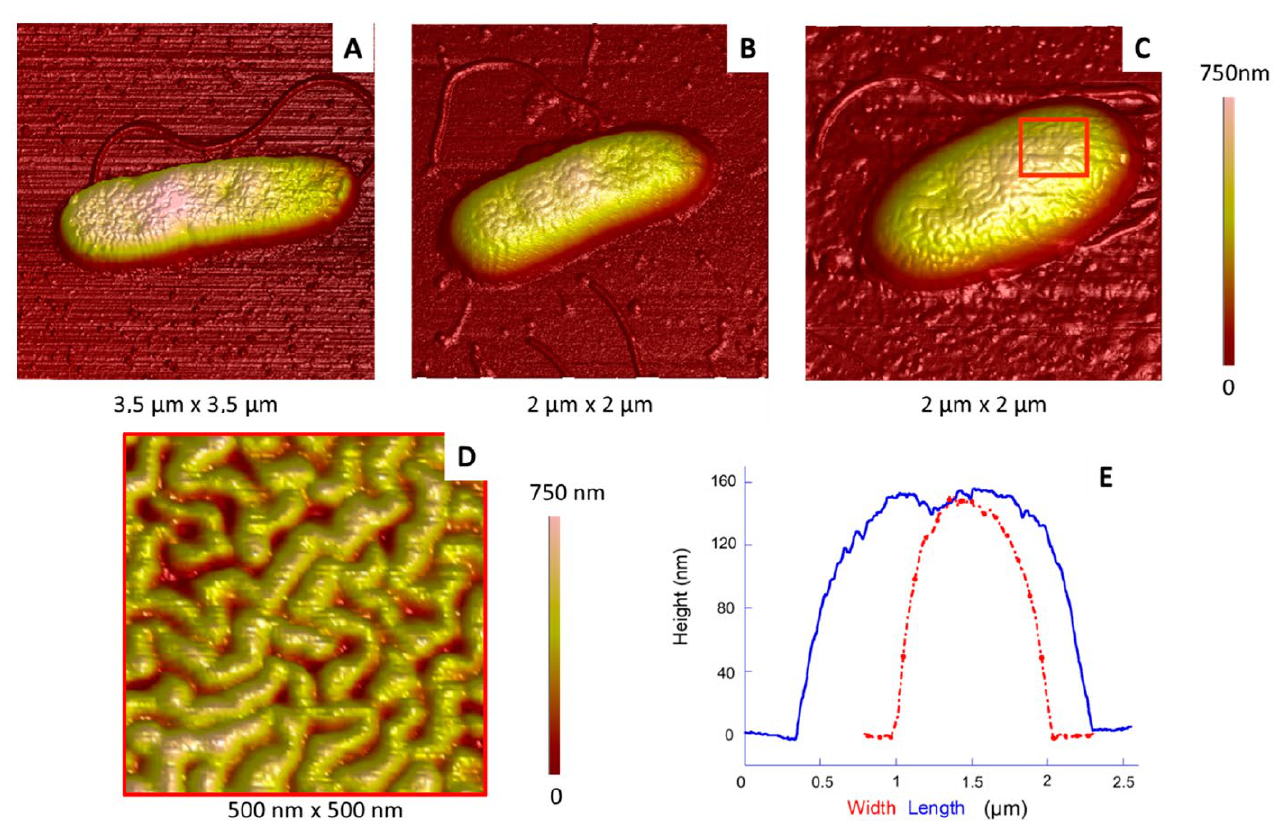
Figure 3. Morphological analysis of P. fluorescens cells. ( A – C ) AFM 3D topography images of isolated cells; ( D ) AFM phase image corresponding to the red square in ( C ); ( E ) height profiles in length (blue) and width (red) of the cell shown in ( C